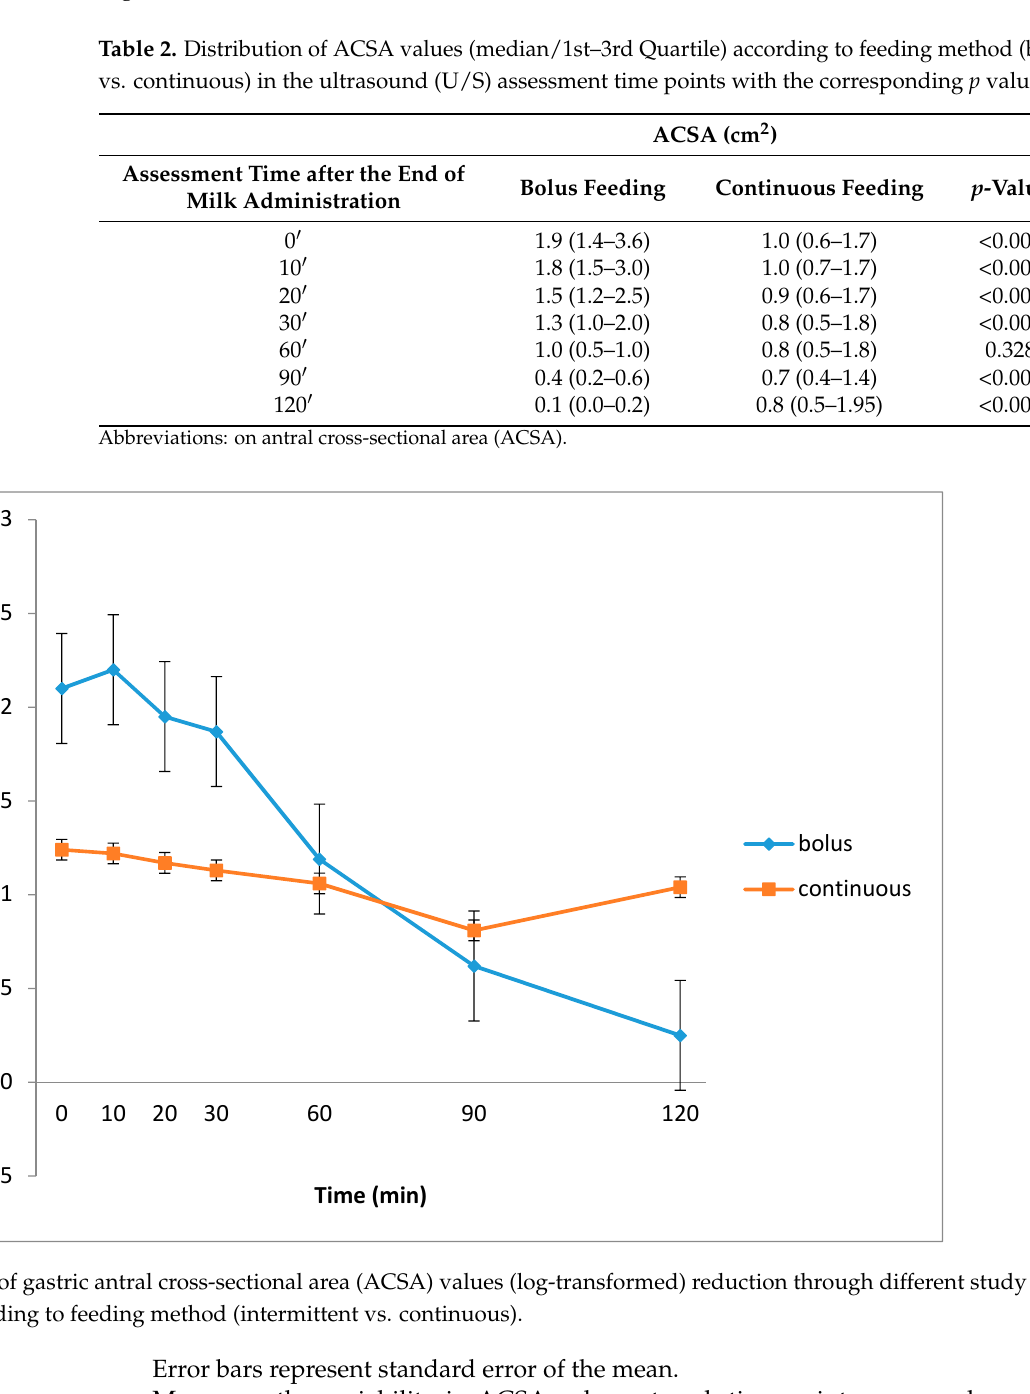
Table 2. Distribution of ACSA values (median/1st–3rd Quartile) according to feeding method (bo- lus vs. continuous) in the ultrasound (U/S) assessment time points with the corresponding p value. ACSA (cm 2 ) Assessment Time after the End of Milk Administration